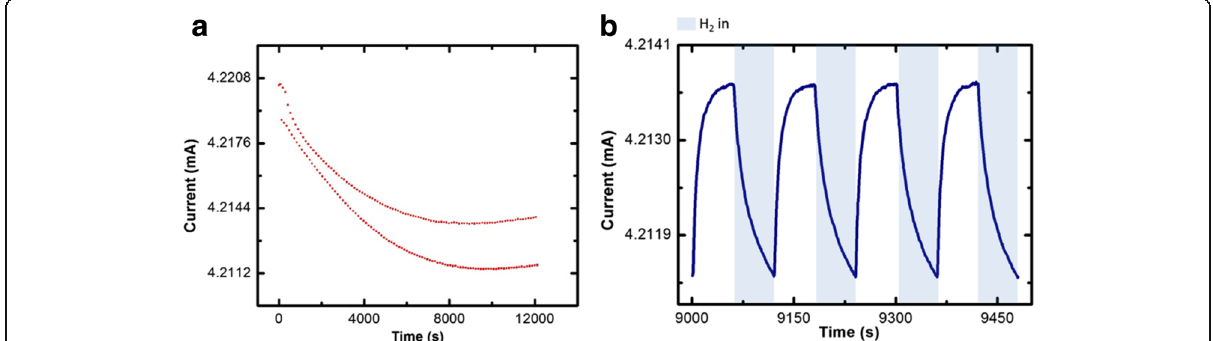
Fig. 5 Hydrogen gas sensing behaviour for UV activated sensor at room temperature. a Maximum and minimum point for 100 cycles. b Response of CuO NWs sensors toward hydrogen gas